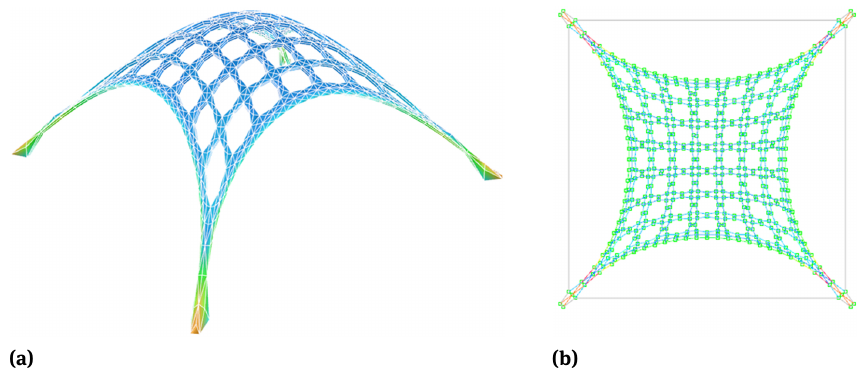
Figure 2: Configuration of the vault after forming with a maximum pierced area percentage of 45.46%. Axonometric view (a). Top view (b)